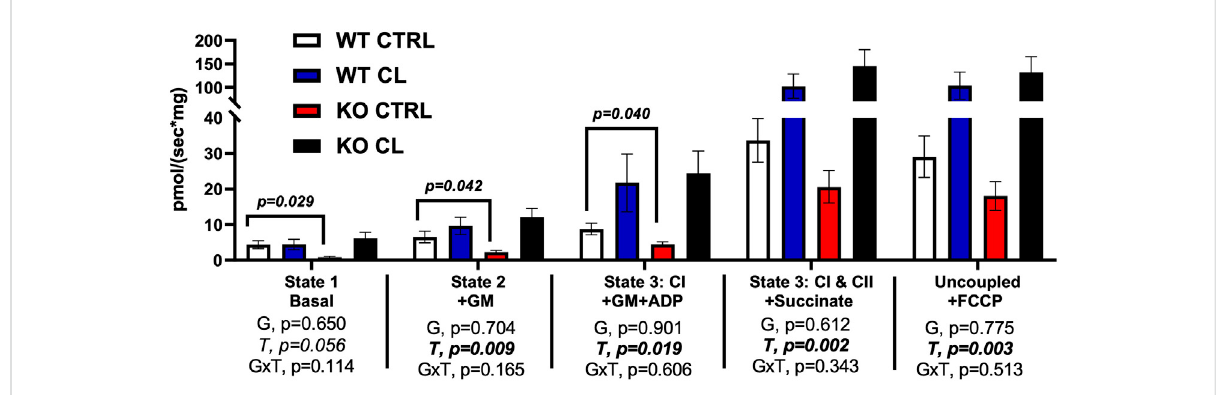
FIGURE 4 Adipocytes from mice lacking ER β genomic activity have lower basal mitochondrial respiration, an impairment completely rescued by CL treatment. Male and female C57BL/6J wild-type (WT) or Estrogen Receptor Beta (ER β ) DNA binding domain knockout (ER β DBD KO) mice, all on HFD, were given 2-weeks CL injection (1ug/g body wight) or CTRL (saline), then perigonadal mitochondrial respiration (i.e., oxygen consumption) was measured via Ouroboros. All data are presented as mean ± SEM. N = 8 – 13 per group. Main effects of genotype (G) and CL treatment (T) and genotype by treatment interactions (GxT) were determined by 2 × 2 ANOVA and are presented below the respective fi gures. T-tests comparing WT and ER β DBD KO controls was also assessed and displayed on graph were signi fi cant. p -value < 0.05 accepted as signi fi cant for all